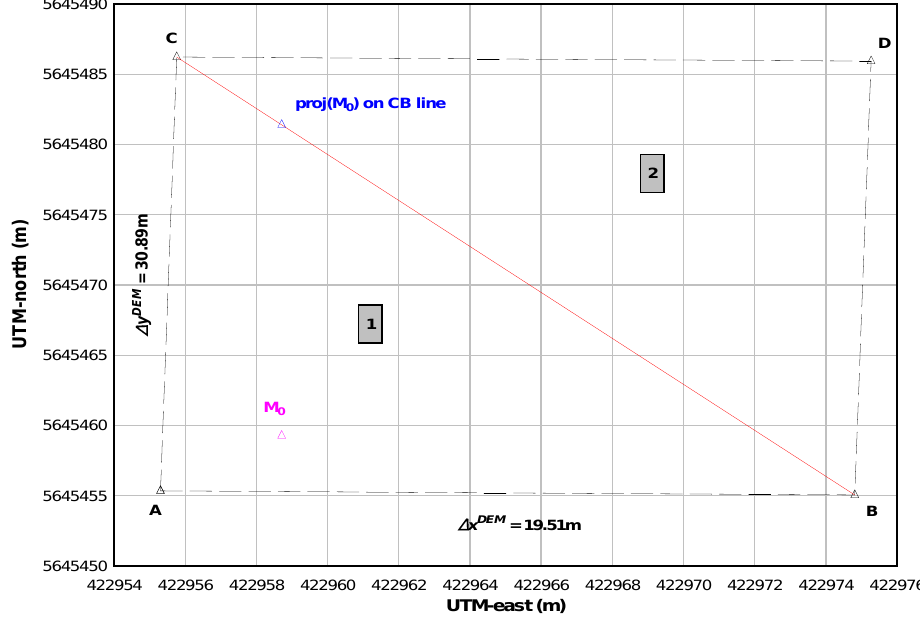
Figure 2. Example of triangulation of the ASTER GDEM2